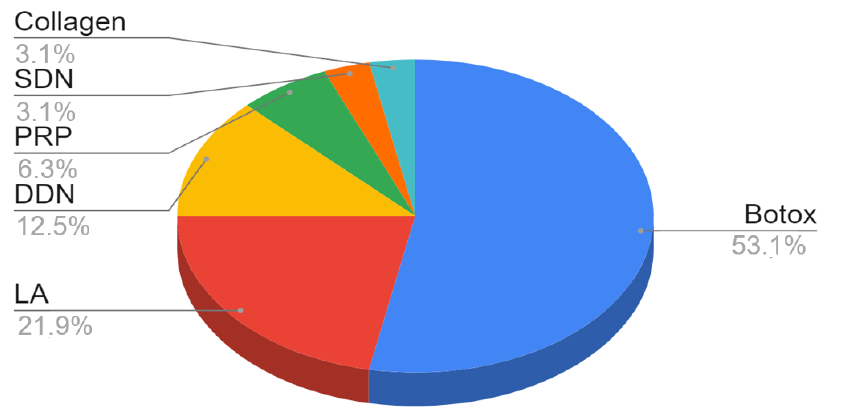
Figure 3. The share of substances injected into the masseter muscles and dry needling in relation to the number of analyzed trials.